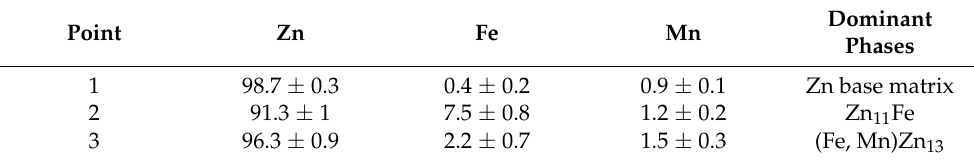
Figure 3. General view obtained by SEM of Zn-2%Fe-0.8%Mn alloy. Table 2. Spot chemical composition by SEM-EDS analysis (wt.%) of different areas shown in Figure